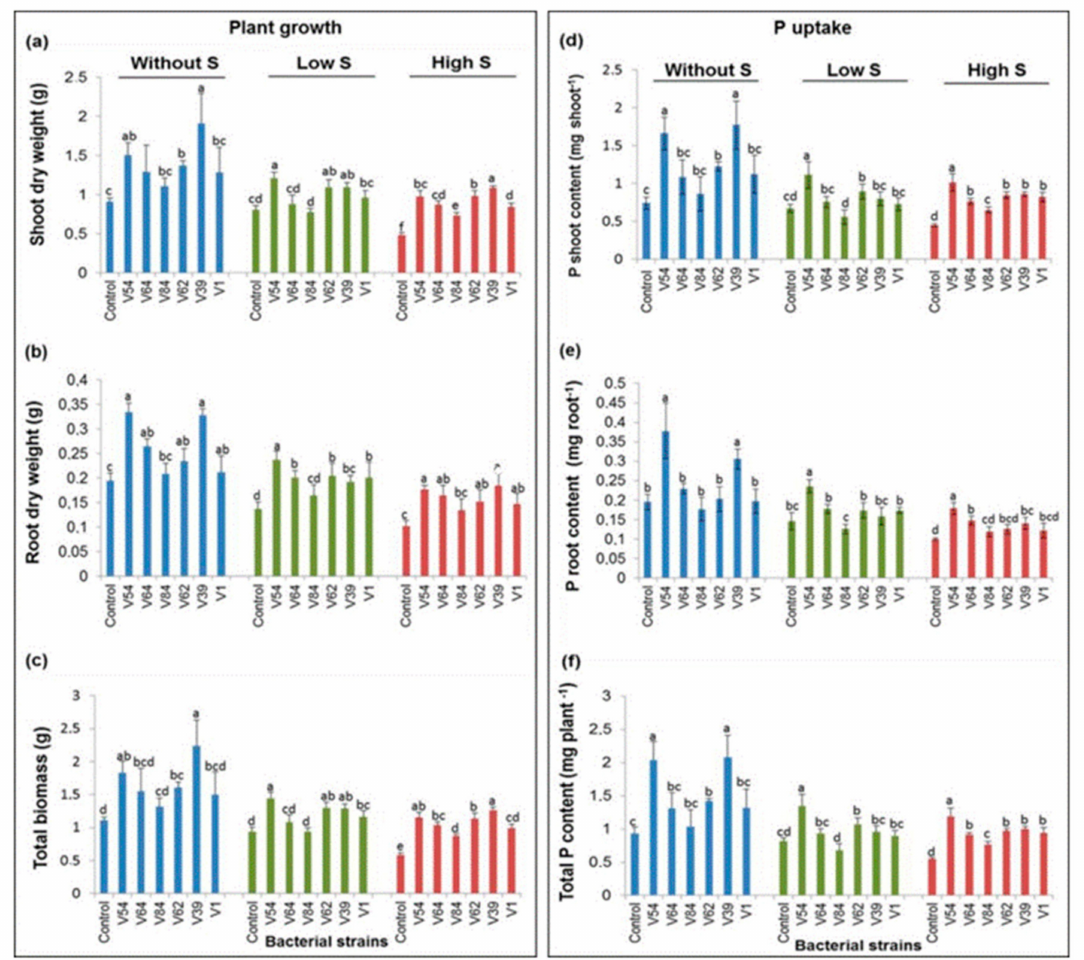
Figure 5. Bacterial inoculations promote tomato plant growth and P uptake under P and salt stress conditions. E ff ects of bacterial strains compared to the non-inoculated control on plant growth: ( a ) shoot, ( b ) root, ( c ) total biomass, and plant P uptake in ( d ) shoot, ( e ) root, and ( f ) total P contents. Tomato plants grown under P stress and di ff erent levels of salt stress were assessed six weeks after planting in a greenhouse. Values are means of five replications and error bars are the standard deviation. The di ff erent letters above the error bars indicate significant di ff erences between treatments within a specific stress ( p < 0.05) using the Tukey HSD test. All plants were under phosphorus stress, amended with hardly accessible Cameroonian RP (CRP). Without S = phosphorus stress without salt stress, Low S = phosphorus stress + low salt stress, and High S = phosphorus stress + high salt stress. Control (non-inoculated), V54, V64, and V84 ( Arthrobacter sp.), V62, V39, and V1 ( Bacillus